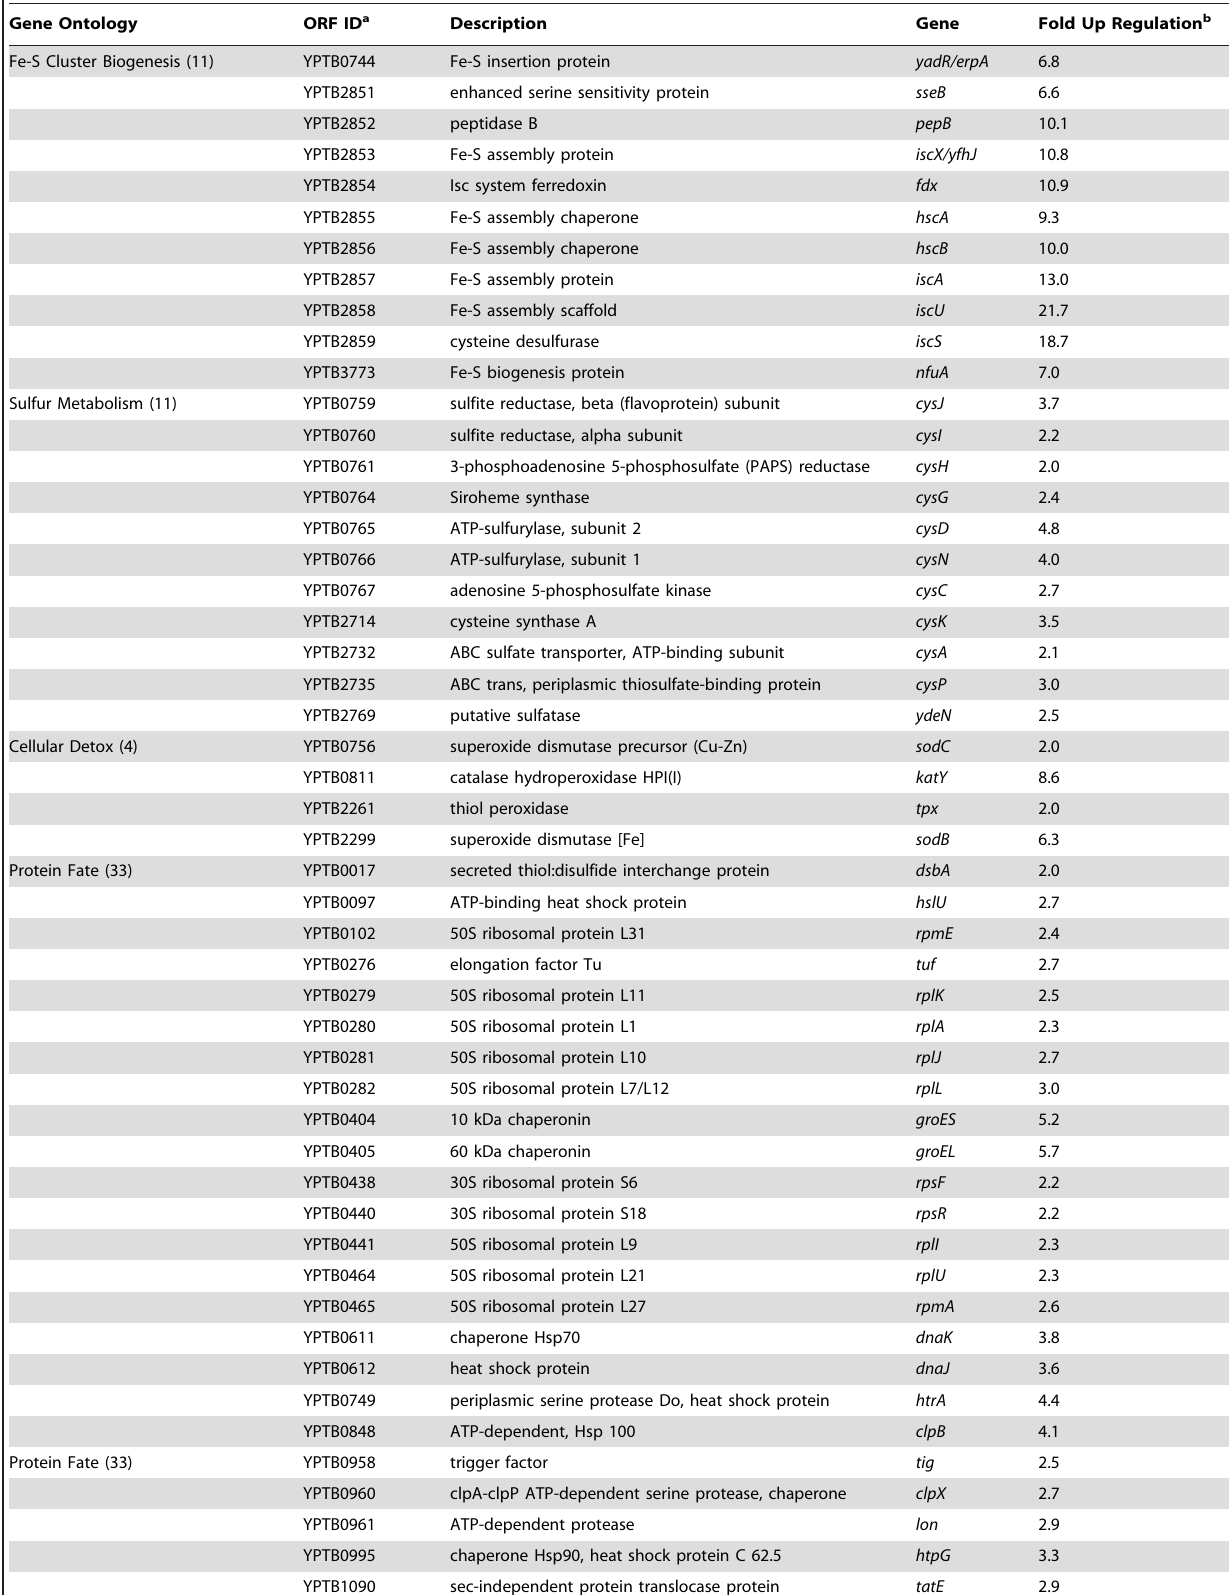
Table 1. Genes repressed by IscR, identified by RNAseq